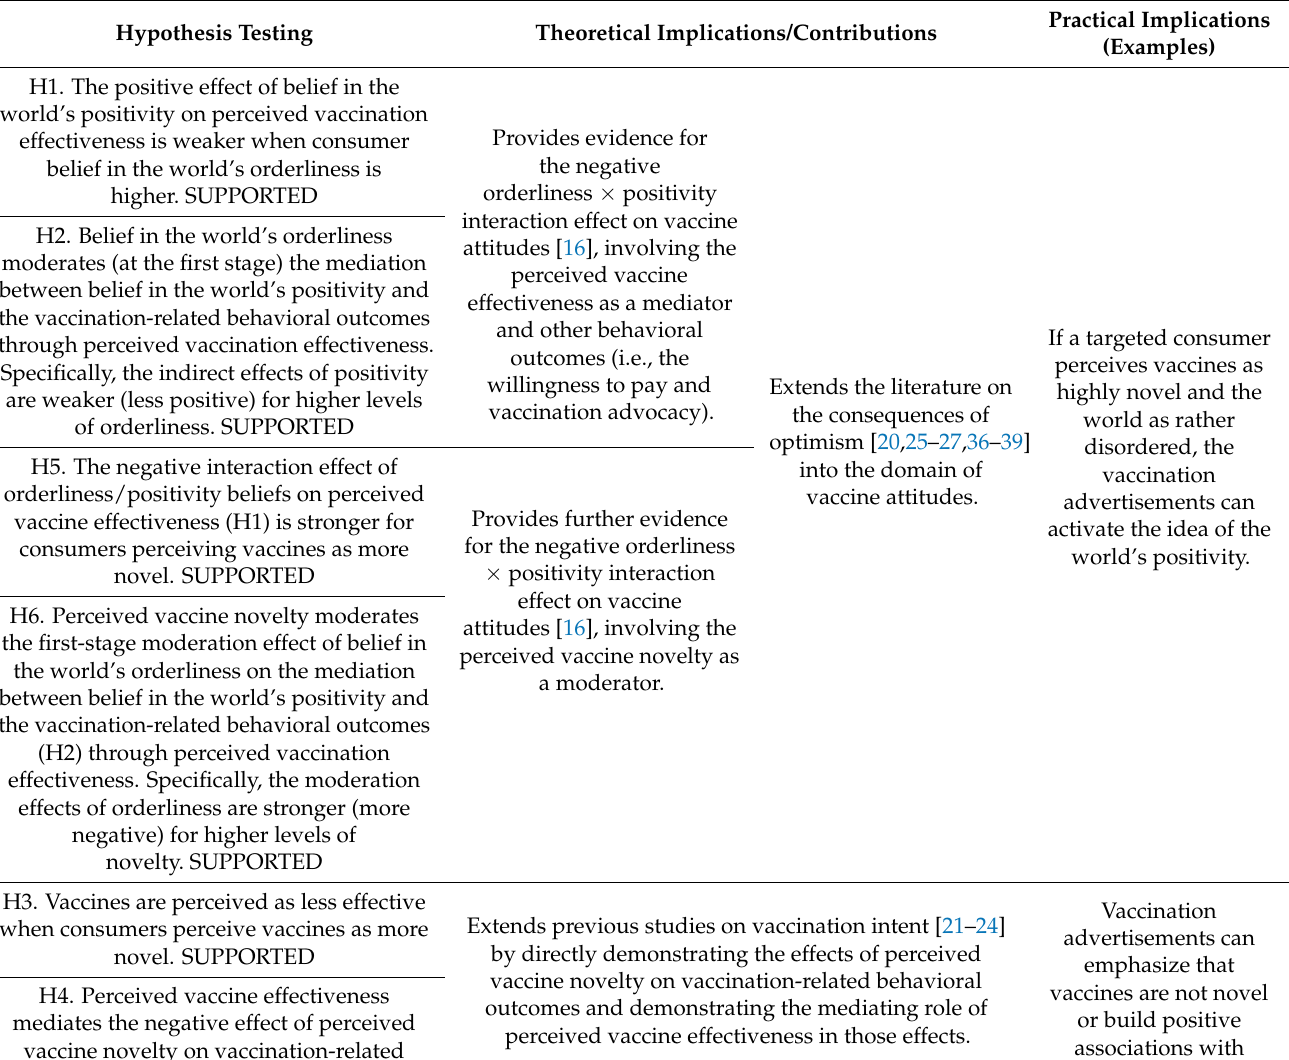
Table 2. Overview of the results and